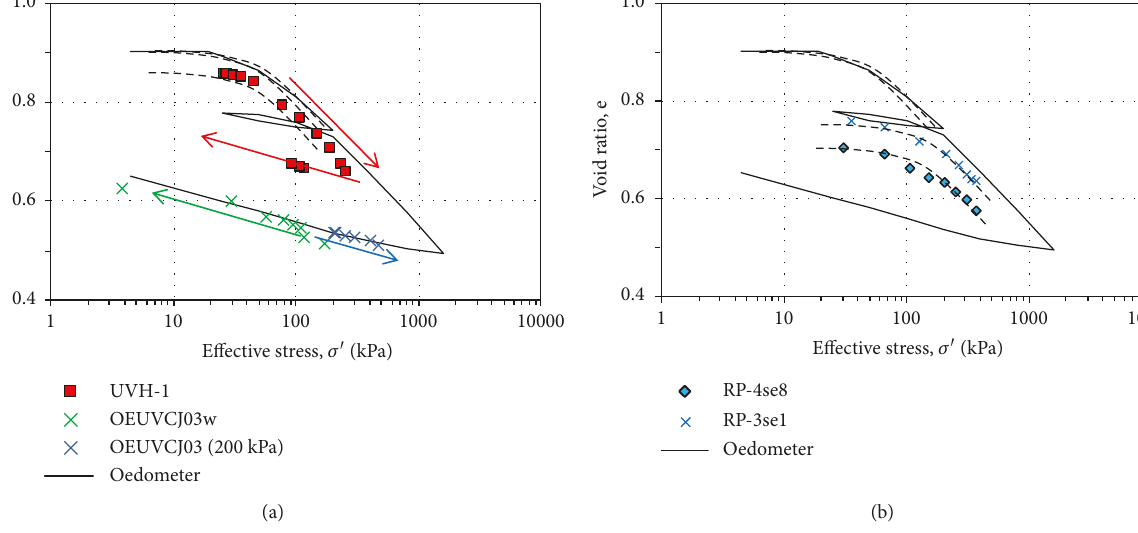
Figure 8: Results in terms of σ ′ - e compared with the conventional oedometer test results for the (a ) UVH-1, OEUVCJ03w, and OEUVCJ03 and (b) RP-3se1 and RP4-se8